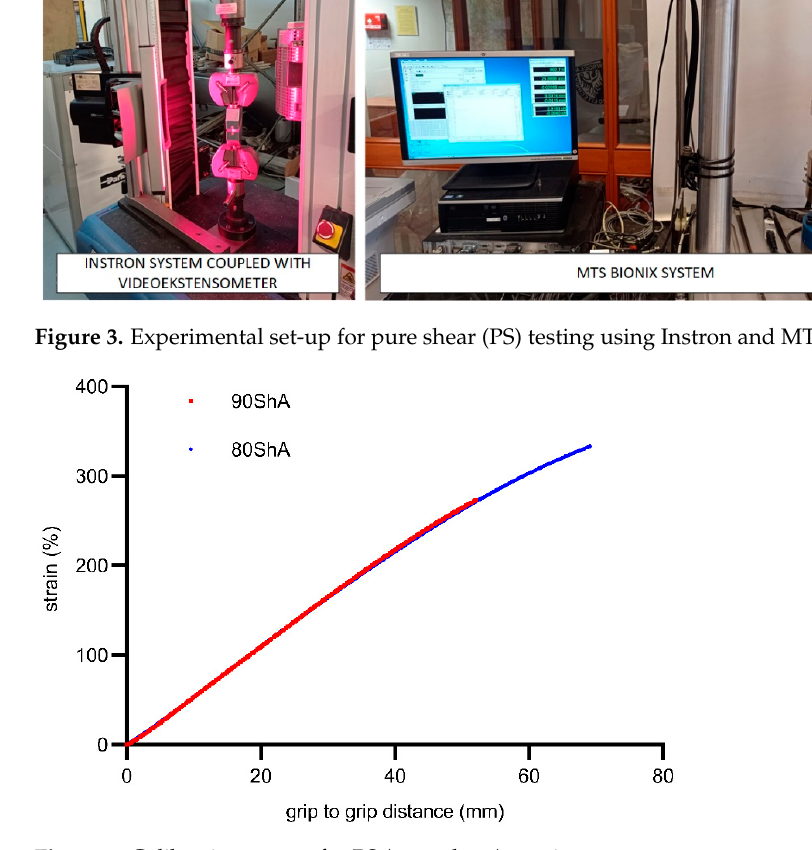
Figure 4. Calibration curves for PS (pure shear) specimens .